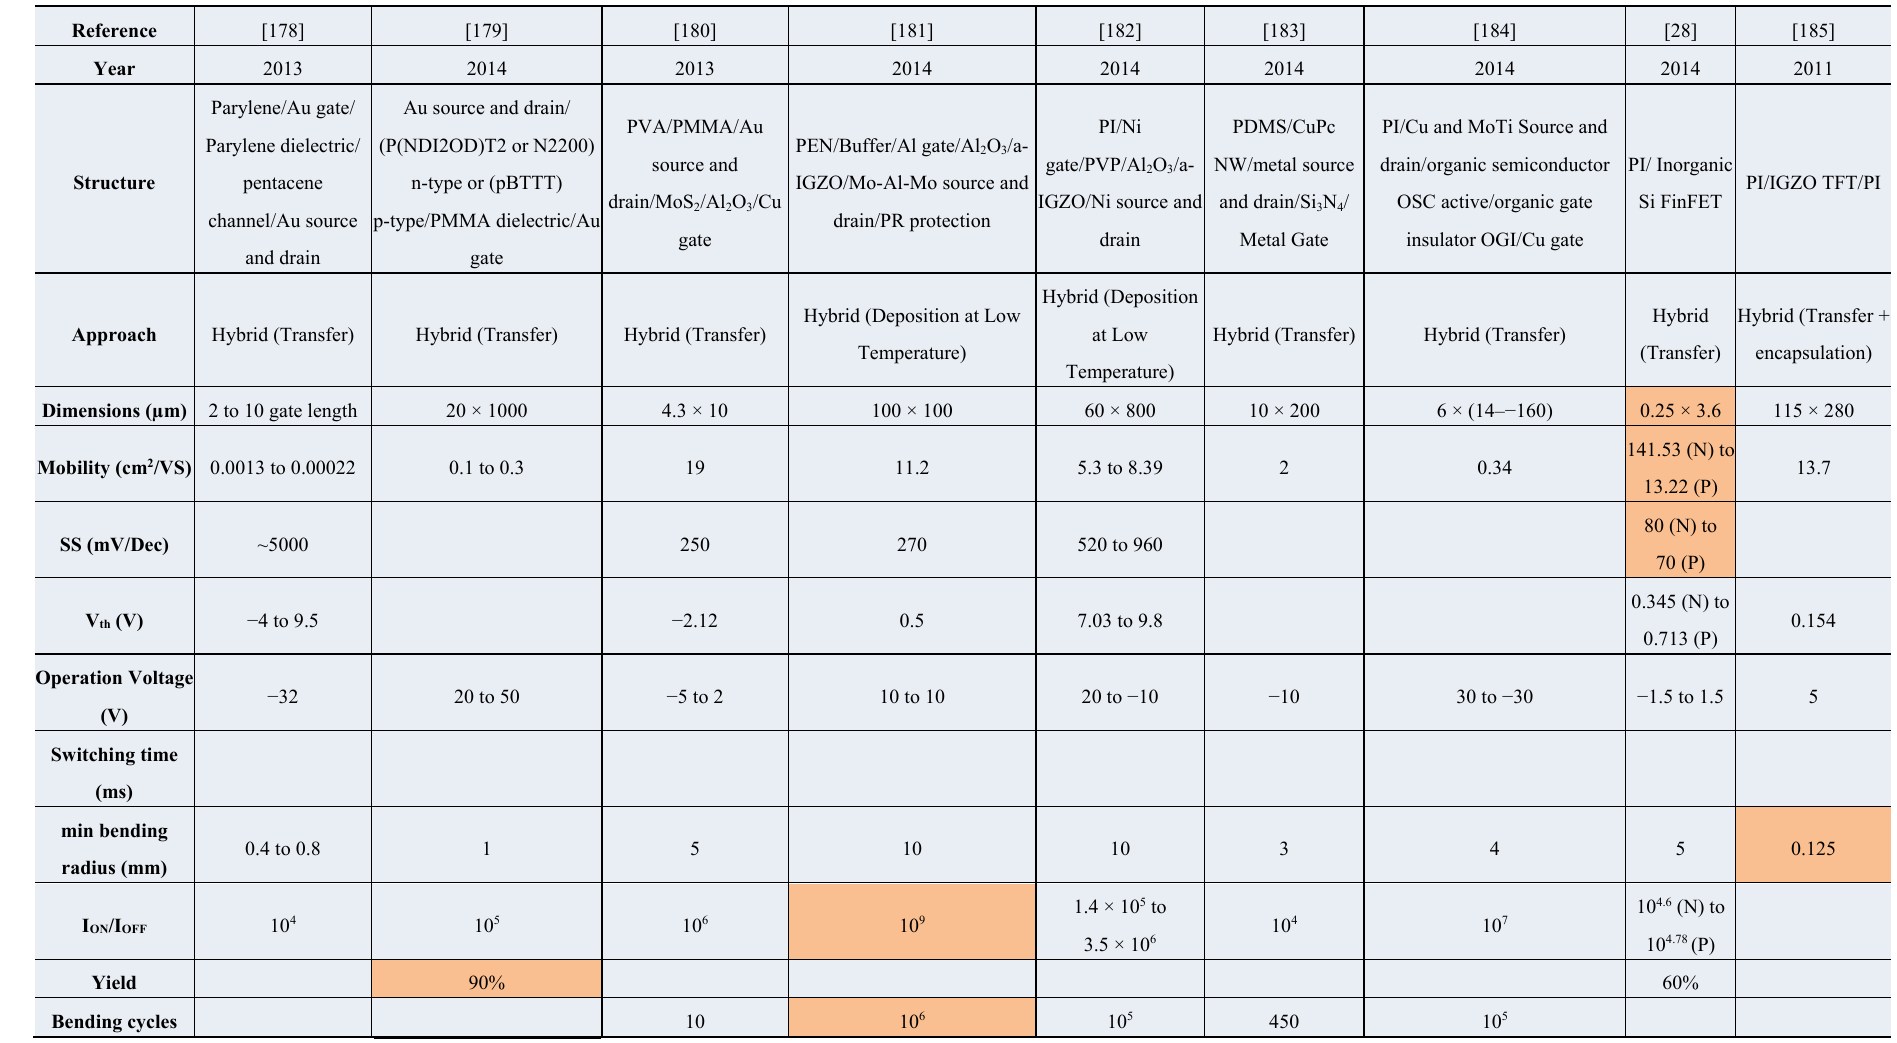
Table 3. Summary of demonstrated hybrid flexible devices over the past